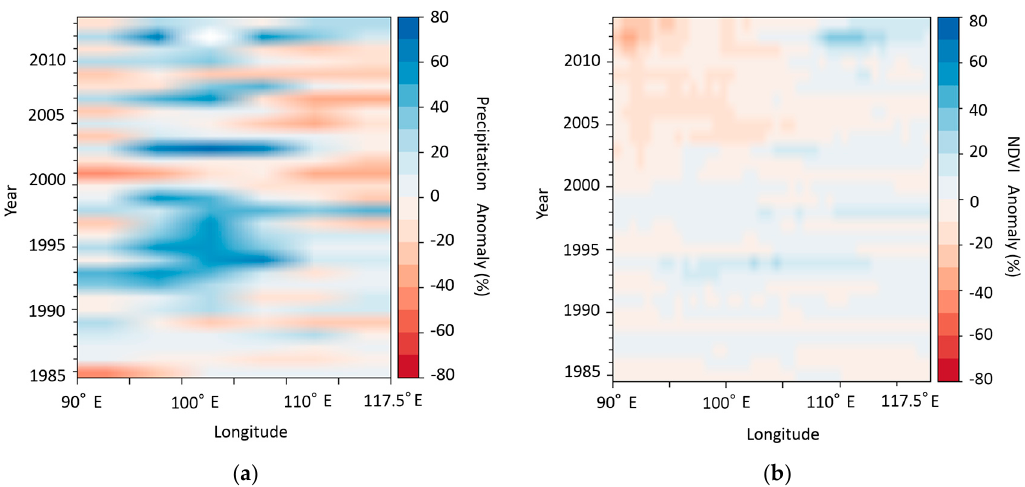
Figure 3. Hovmoller diagrams: ( a ) precipitation anomaly and ( b ) NDVI anomaly for the Gobi region averaged between 90° E–117.5° E and 40° N–47.5° N.